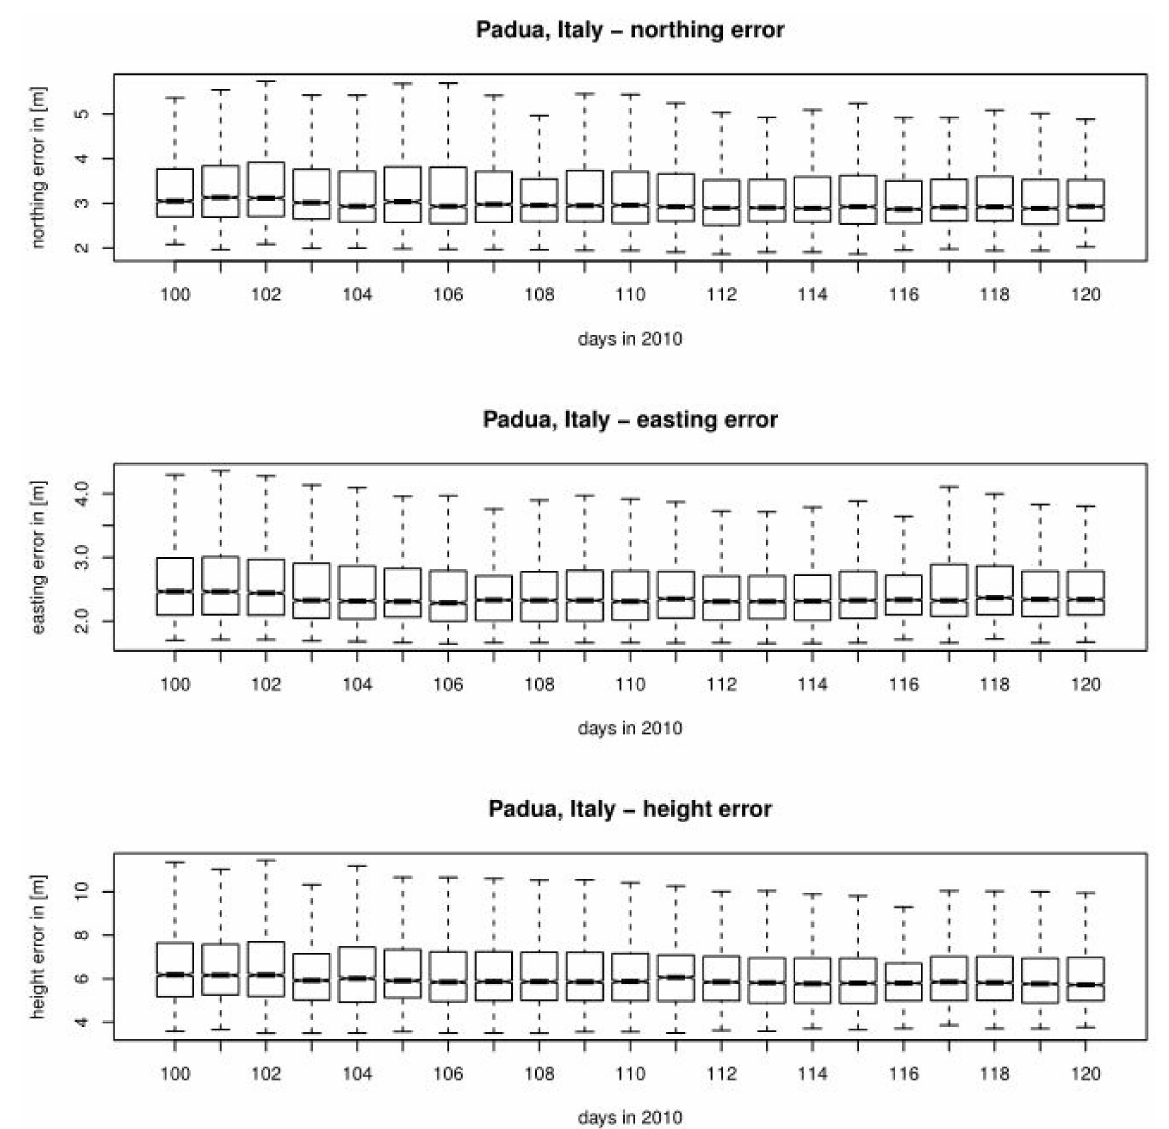
Figure 9. Box-and-whisker plot of GPS positioning errors as observed at Padua, Italy reference station during days 100–120 in